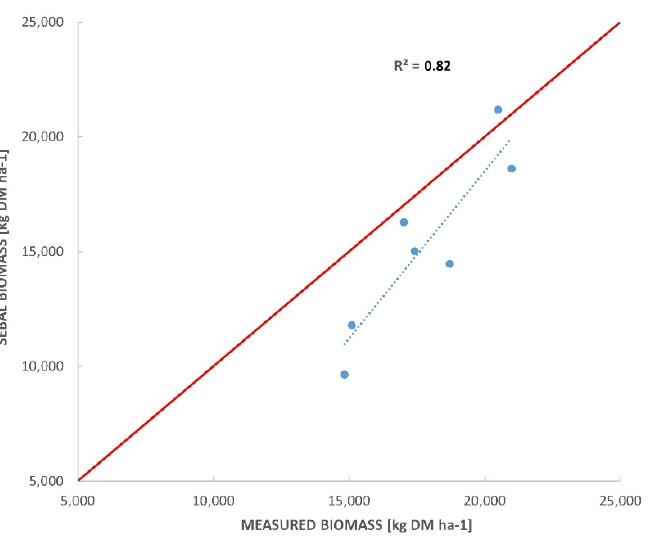
Figure 5. Comparison between measured aboveground biomass from hand-harvested plant samples (x axis) and SEBAL-estimated aboveground biomass (y axis) for all the different experimental areas. Values are expressed as kg DM ha − 1 . The 1:1 line is reported in red. SEBAL-based yields, calculated using literature HI (0.4, 0.45 and 0.5) values, are shown in Table 2. The relative errors calculated using the actual HI for damaged, not damaged, and all (damaged+not damaged) were, by far, the lowest. In fact, SEBAL-derived